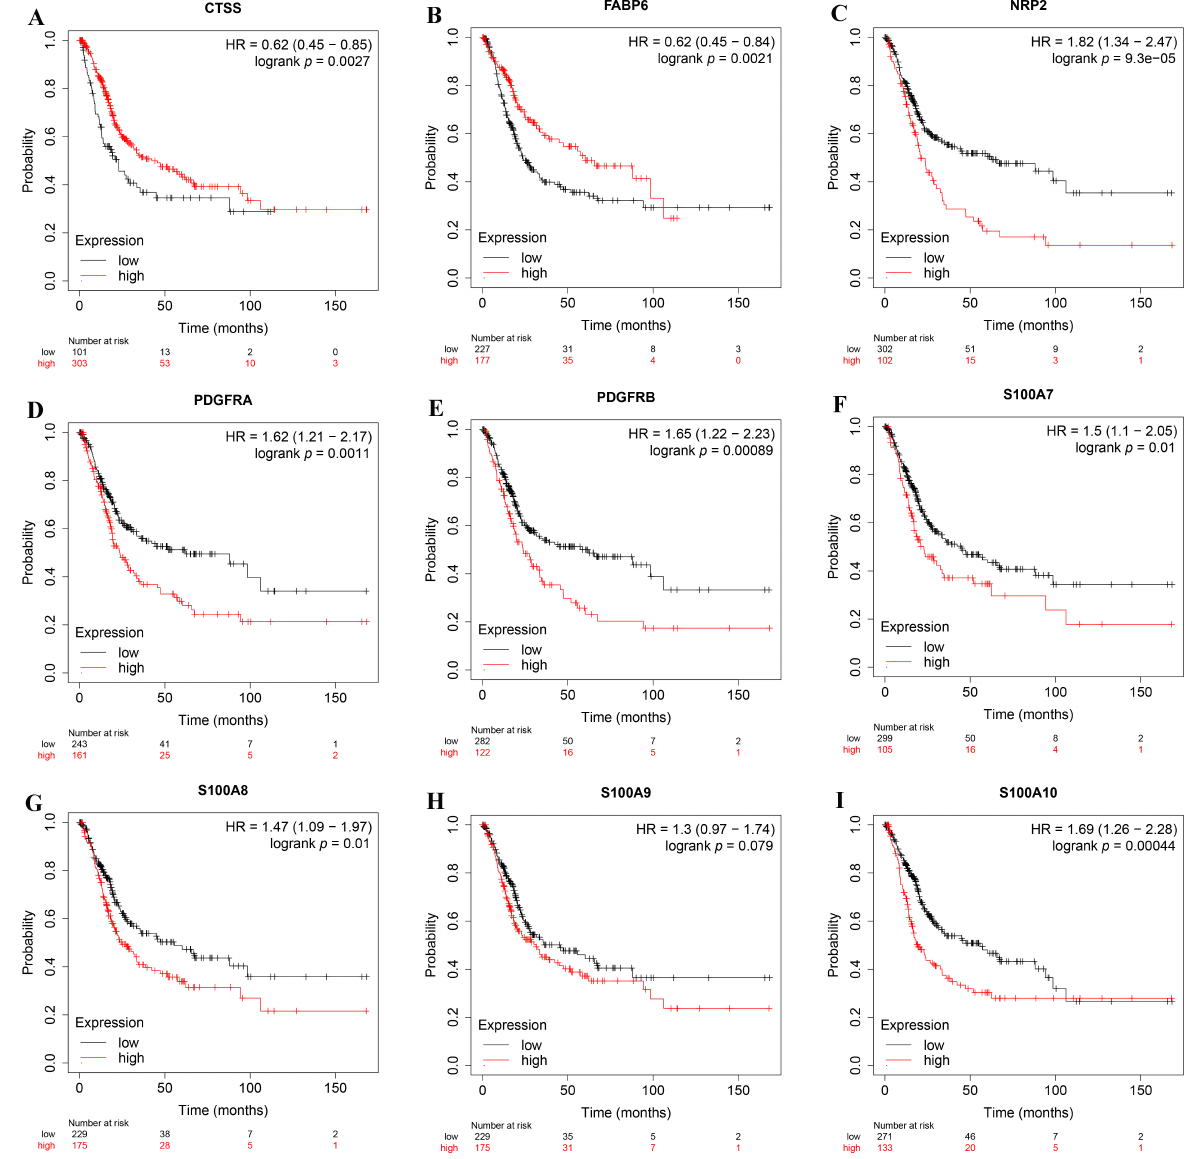
Figure 8. The expression levels of genes used to construct IRPM on the prognosis of BLCA using the Kaplan–Meier Plotter database. ( A ) CTSS; ( B ) FABP6; ( C ) NRP2; ( D ) PDGFRA; ( E )